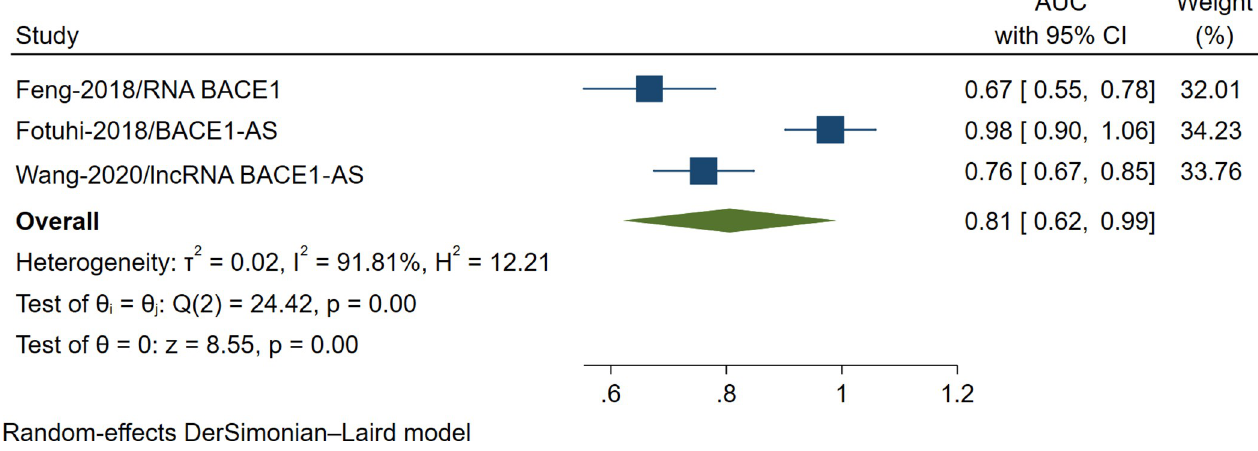
Fig 4. Forest plot of the meta-analysis of diagnostic accuracy of BACE1-AS lncRNA in AD vs. HCs (AUC).